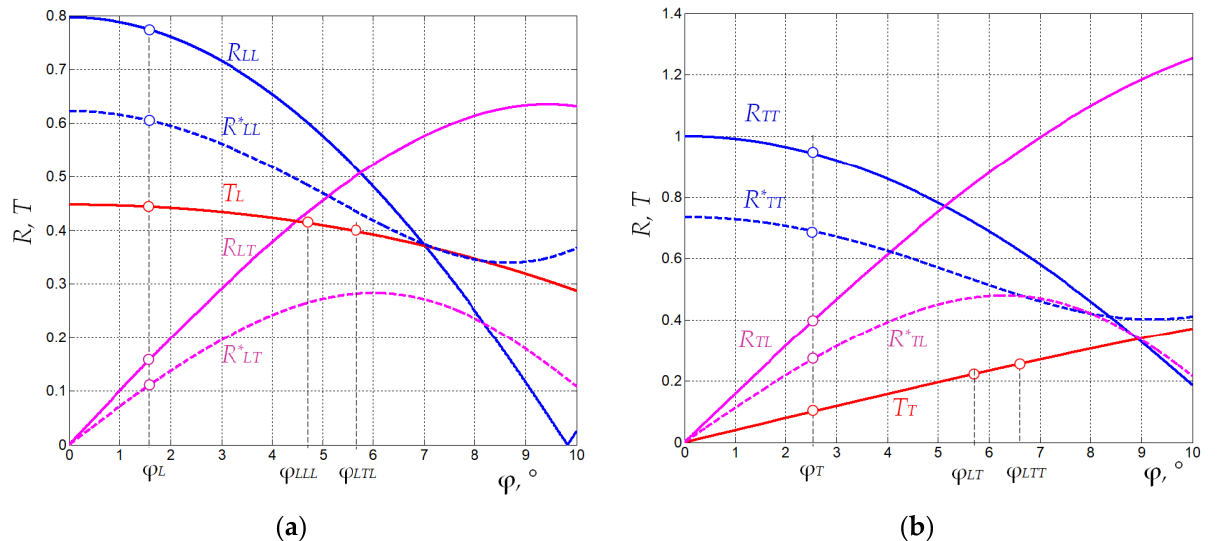
Figure 6. ( a ) Reflection coefficients R LL , R * LL , R TT and R * TT , transmission coefficients T L , and T T , mode conversion coefficients R LT , R * LT , R TL and R * TL for the interfaces fused quartz–water (solid lines) and fused quartz–absorber (dashed lines) vs refraction angle in water ϕ : longitudinal ( a ) and transverse ( b ) waves in